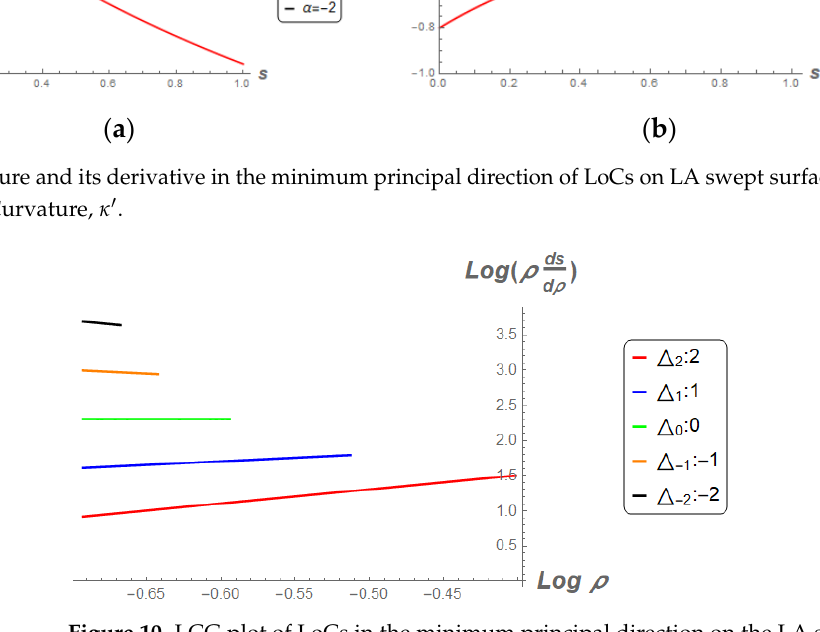
Figure 10. LCG plot of LoCs in the minimum principal direction on the LA swept surfaces.